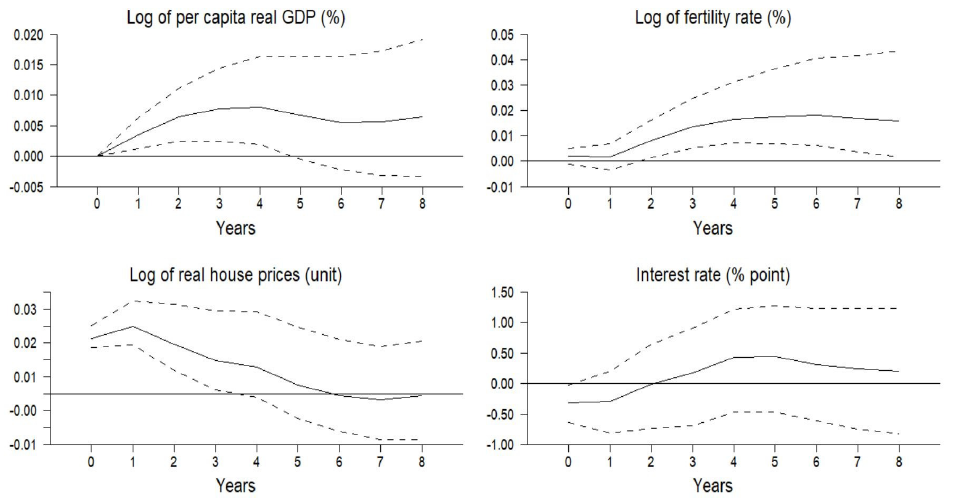
Figure 6. Responses to a house price shock in the baseline structural VAR when the Shiller home price index is replaced by the all-transactions house price index in the model.